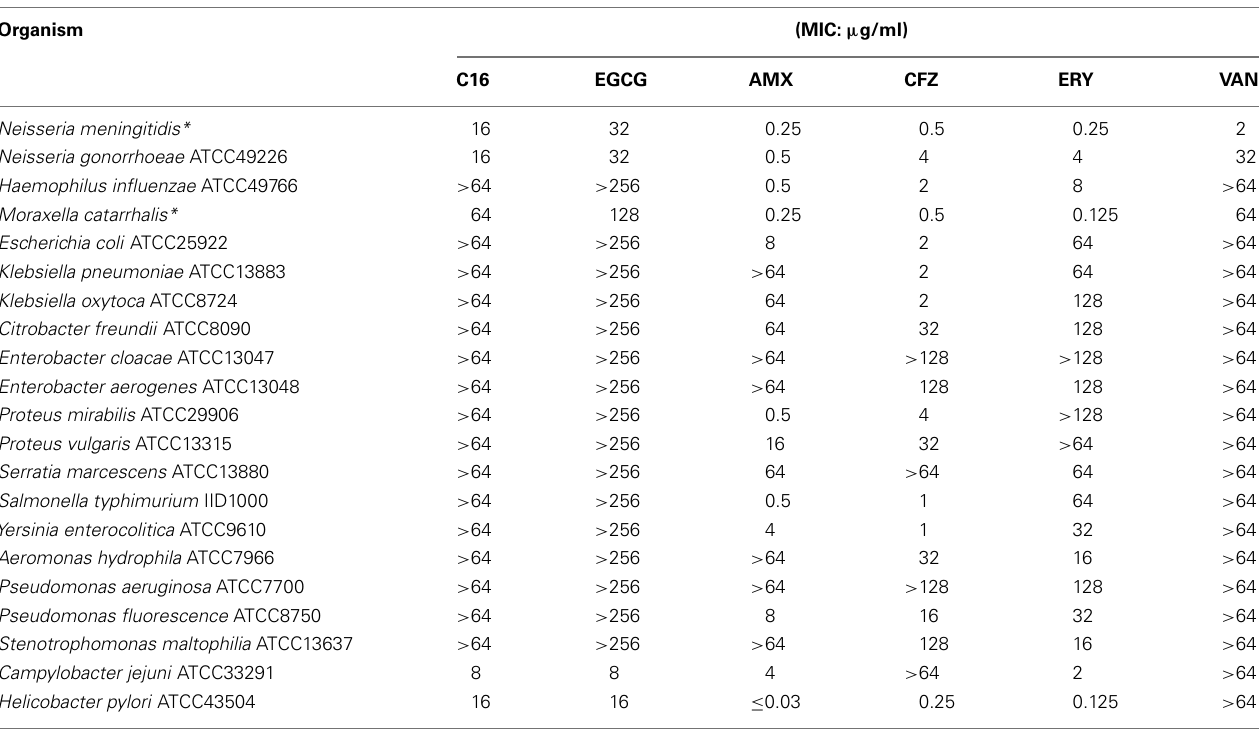
Table 4 |Antibacterial activities of C16 against Gram-negative bacteria.